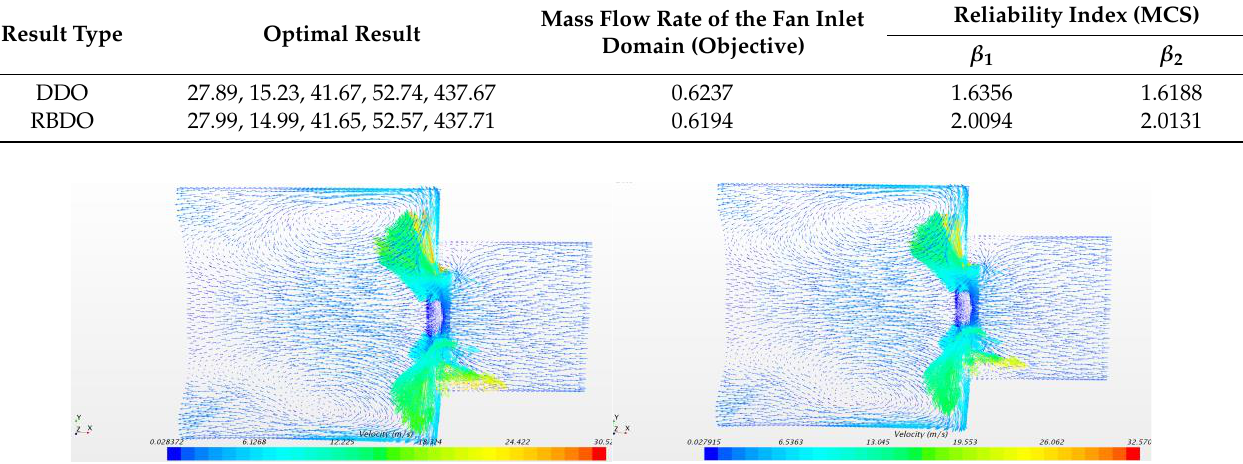
Table 10. Results comparison of DDO and RBDO.